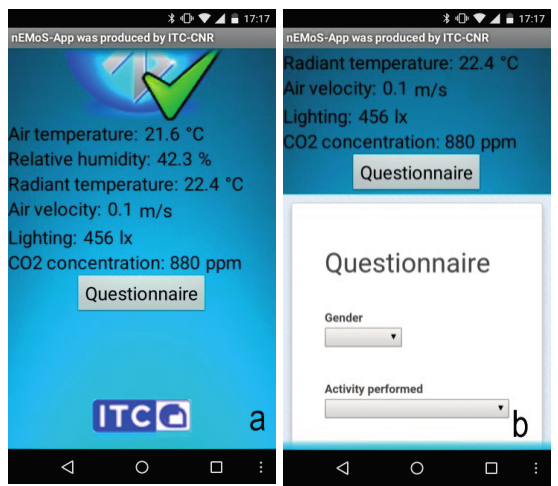
Figure 2. ( a ) nEMoS-App: variables as shown; ( b ) nEMoS-App: first part of the questionnaire.